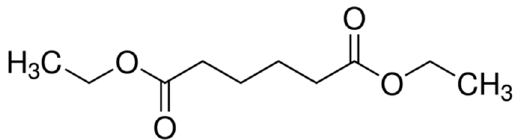
Figure 5. Structural formula of DEA.